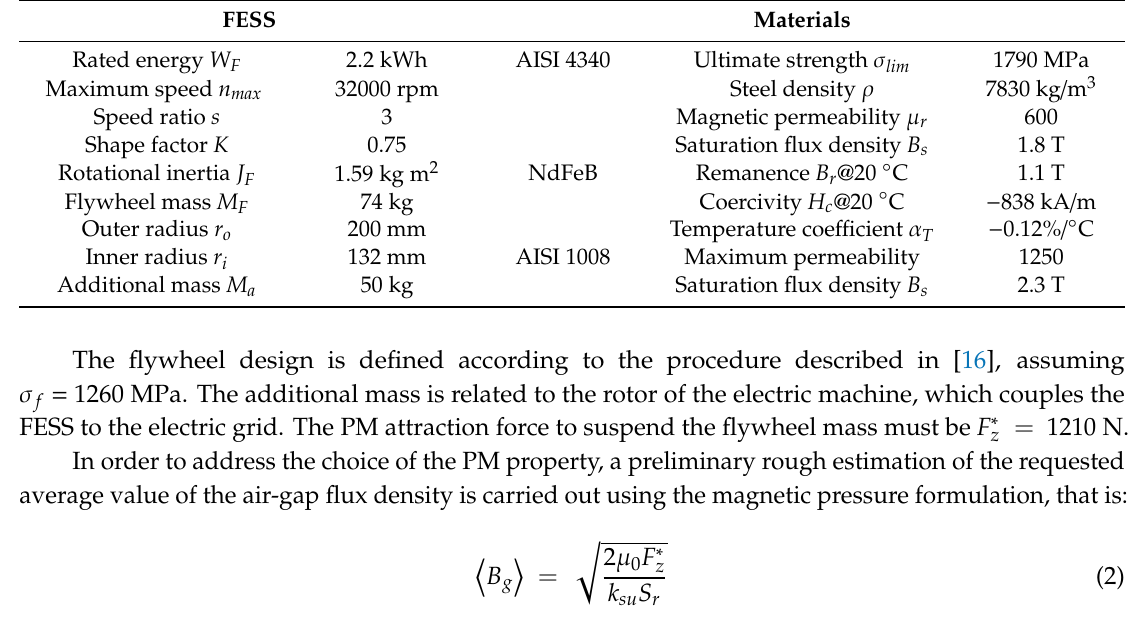
Table 1. Main FESS data and material